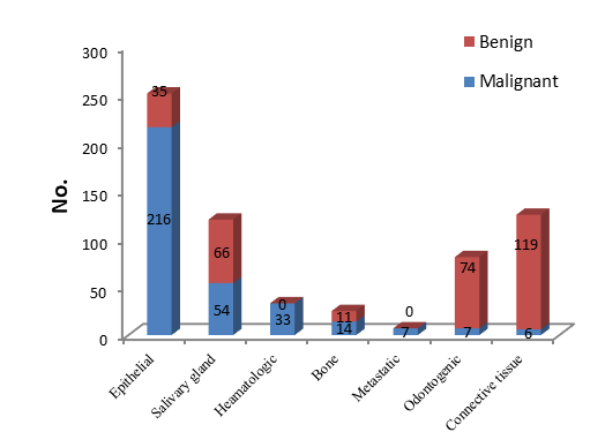
Figure 3 : The major histopathological cell origin categories of oral neoplastic